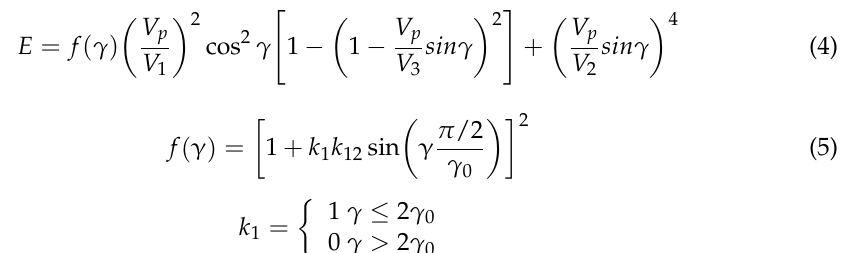
Table 1. Sediment condition. Parameter Flow rate (m 3 /s) 0.25 Q d particle concentration (kg/m 3